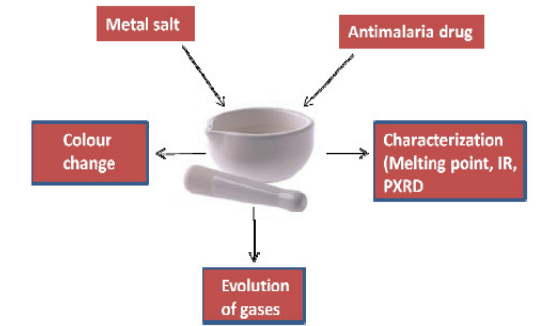
Fig. 1. Schematic diagram of mechanochemical